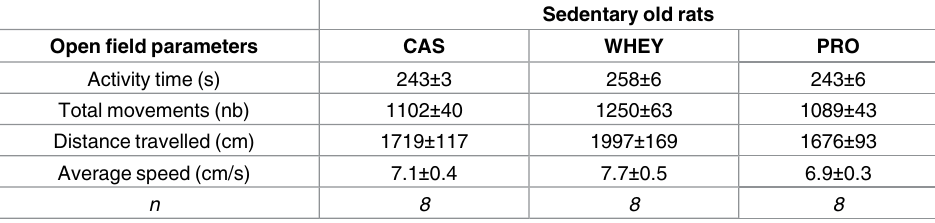
Table 6. Sedentary old rats exhibited similar locomotion capacities regardless of the protein